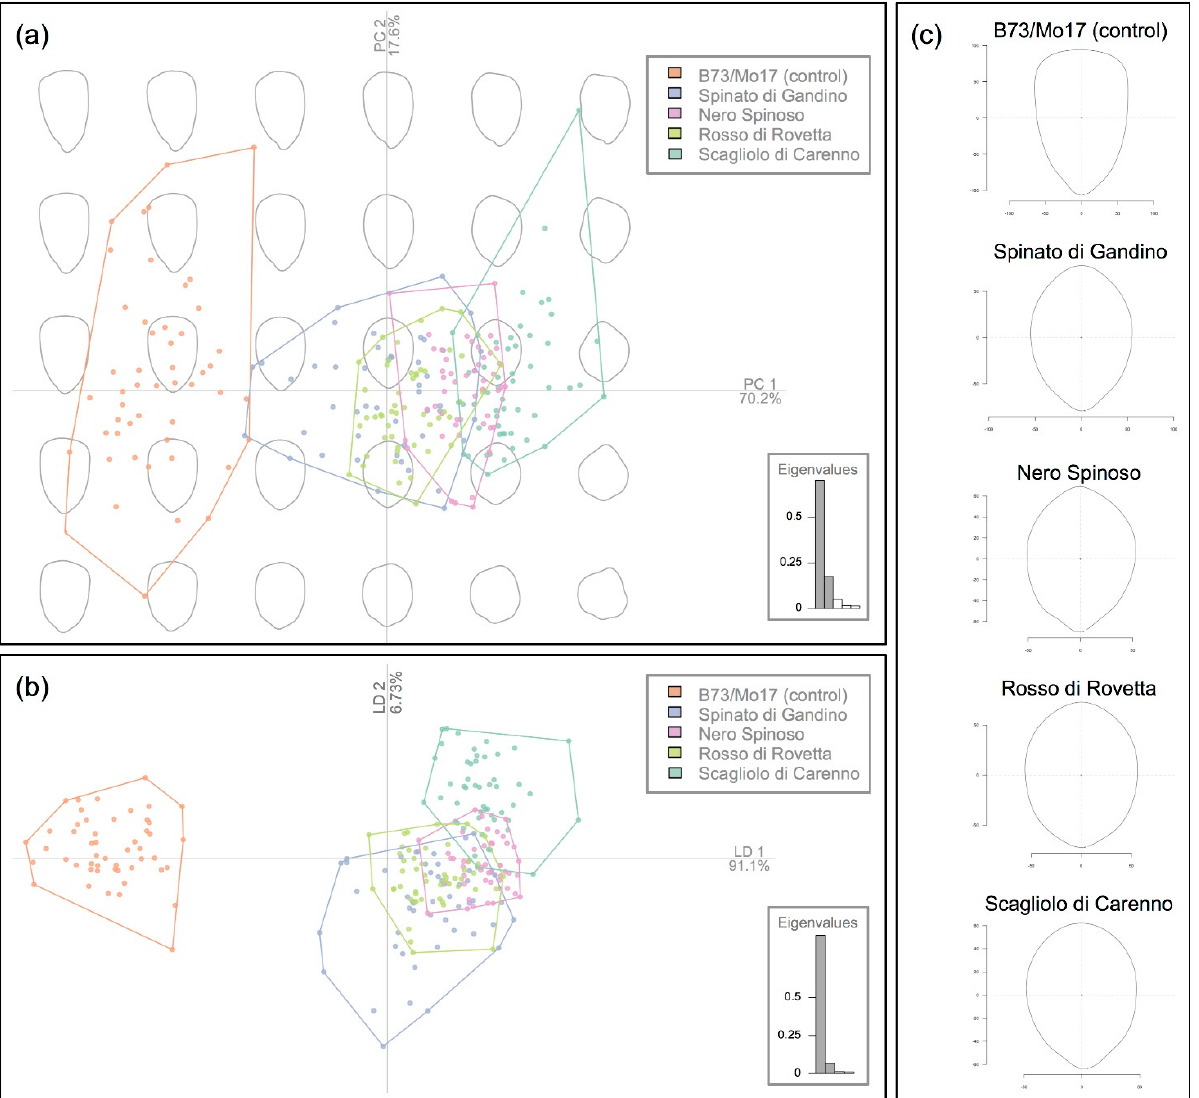
Figure 2. PCA biplot ( a ) resulting from outline analysis of the kernels of the five maize genotypes, LDA of PCs biplot ( b ) and mean shape of kernels ( c ), assigned according to elliptical Fourier descriptors analysis. Gray figures in the background of PCA biplot ( a ) show reconstructions of kernel shape according to each position in the multidimensional space.